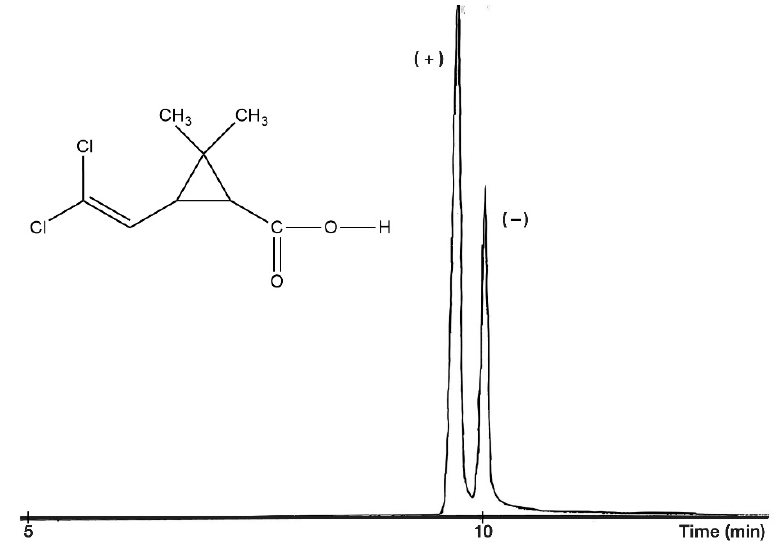
Figure 6. Chiral separation of trans ‐ permethrinic acid methyl ester. Conditions: instrument, Shimadzu GC/MS ‐ QP5000 GC/MS; column, 25 m × 0.22 mm; stationary phase, Cydex ‐ B (0.25 μ m); carrier, He (50 cm/s); temperature, 160 °C.